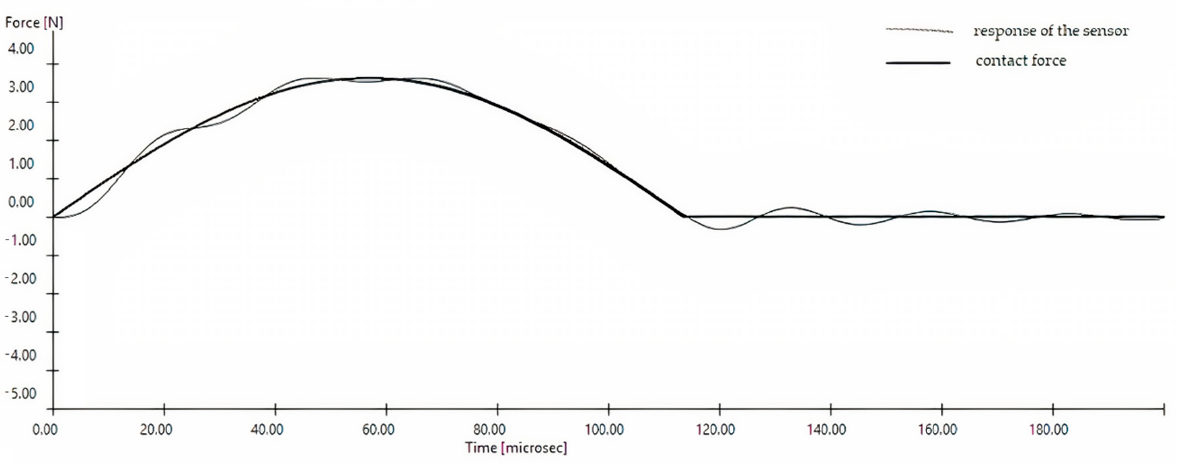
Figure 5. The course of the impact force and measurement signal from the sensor for a large moist grain. Contact stiffness k 1 = 1 × 10 4 Nm − 1 , f rez = 40 kHz.